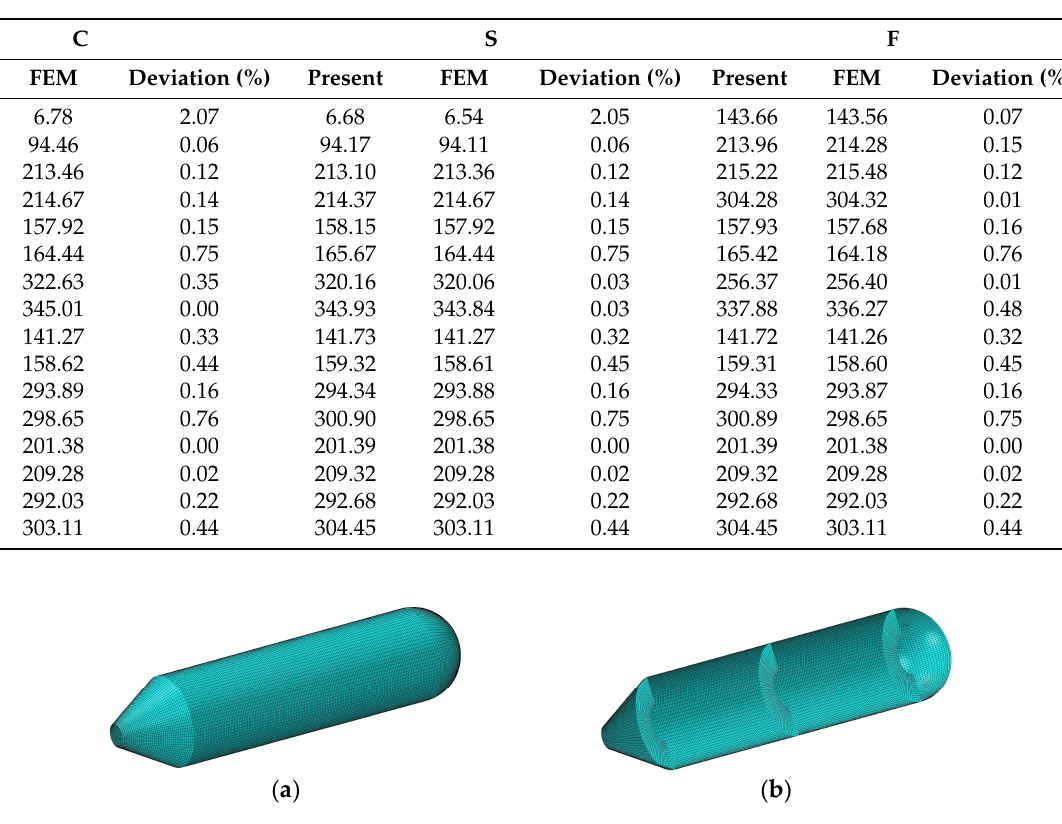
Figure 3. FEM model of submarine-like structure. ( a ) Overall view of FEM model of submarine-like structure; ( b ) Axial section view of FEM model of submarine-like structure. Table 1. Comparison of calculation frequency of spherical, conical, and cylindrical shell with lami- nated material.